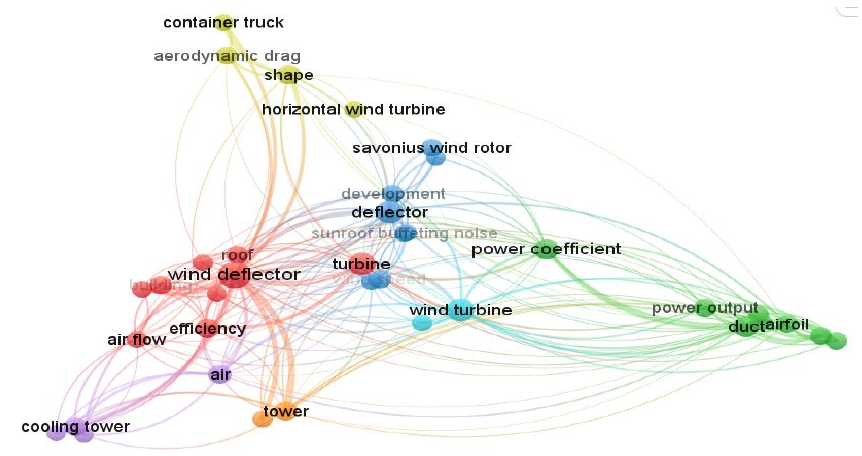
Figure 5. Bibliometric analysis of selected papers for data extraction.